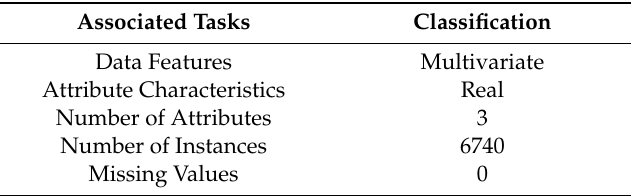
Table 1. Dataset